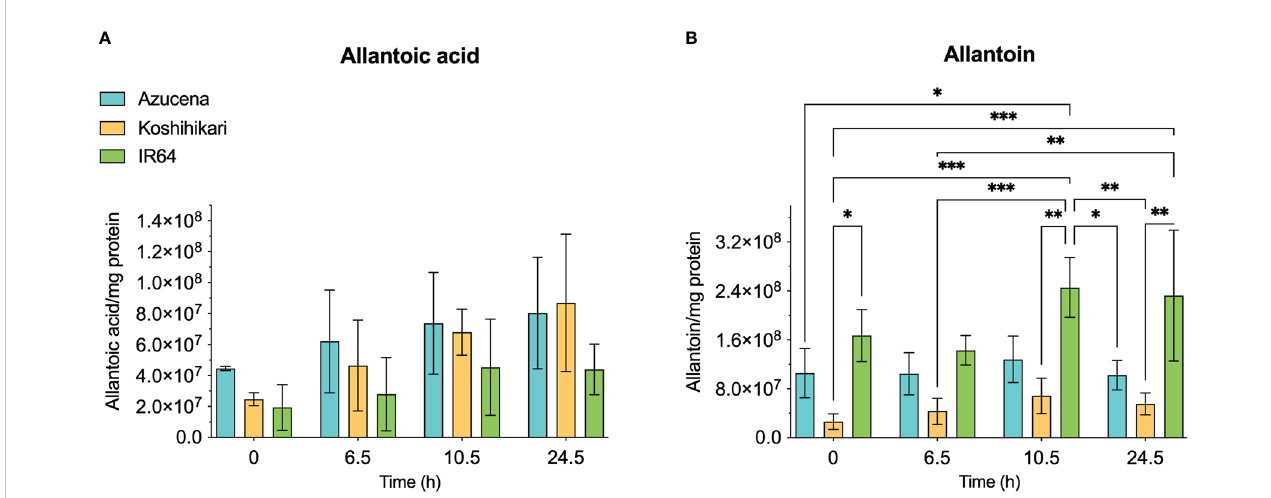
FIGURE 6 Levels of selected metabolites of purine catabolism in rice leaves during 24 hours of exposure to salt stress. Three rice cultivars were grown hydroponically in a phytotron, and 200 mM NaCl was added to growth media on day 17. Koshihikari and Azucena are salt-sensitive, and IR64 is salt-tolerant. Leaves were harvested during a 24-hour period post-treatment, and the levels of metabolites were measured. Allantoin (B) and allantoic acid (A) are the products of the fourth and fi fth steps, respectively, of xanthine degradation. Values on the y-axis represent the integrated area of peaks associated with the metabolite of interest, normalized to mg protein in the sample. It is important to note that the levels of different compounds cannot be compared. Data were analyzed in a two-way ANOVA using GraphPad Prism 9 (*P values 0.01 - 0.05, ** P values 0.001 – 0.01, *** P values 0.0001 – 0.001).